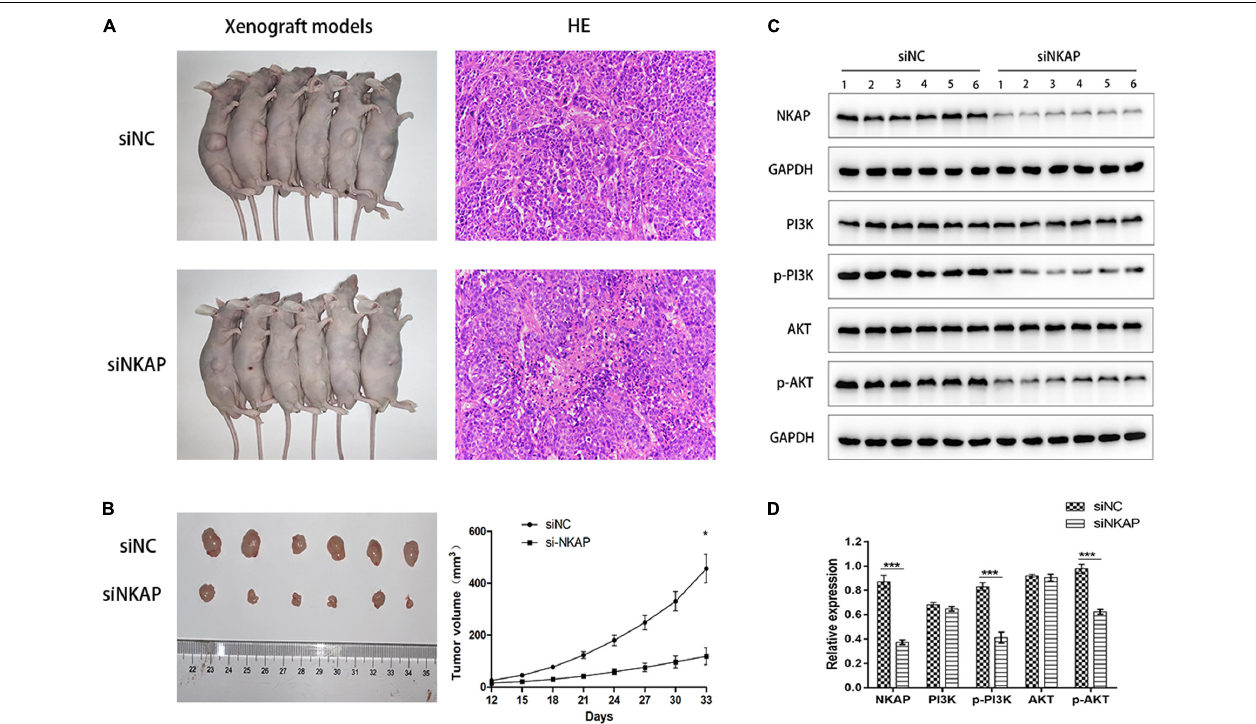
FIGURE 6 | (A) Xenograft models inoculation with SK-N-SH cell transfected with siNKAP or siNC. (B) Xenograft tumors of SK-N-SH cell at 33 days after inoculation with siNKAP and siNC subcutaneously and the growth curves of xenograft models. (C) Function verification of NKAP in PI3K/AKT pathway by Western blot assay in vivo . (D) Quantification of NKAP function in PI3K/AKT pathway. *** P < 0.001, * P <